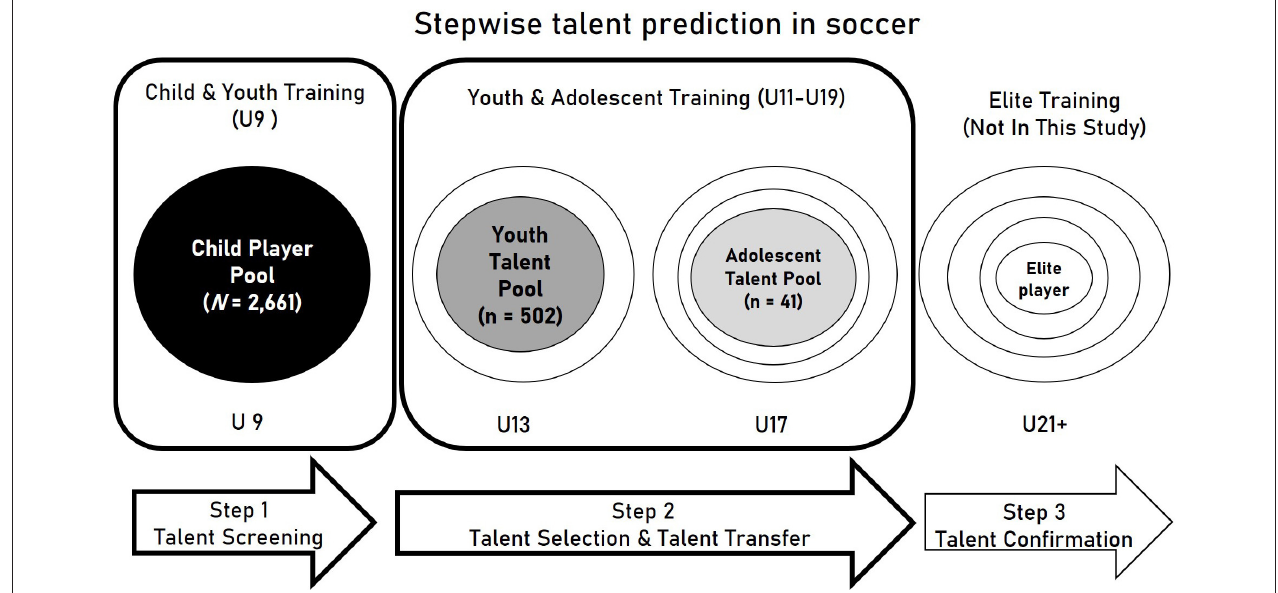
FIGURE 2 | Stepwise talent prediction during the three stages of the talent development